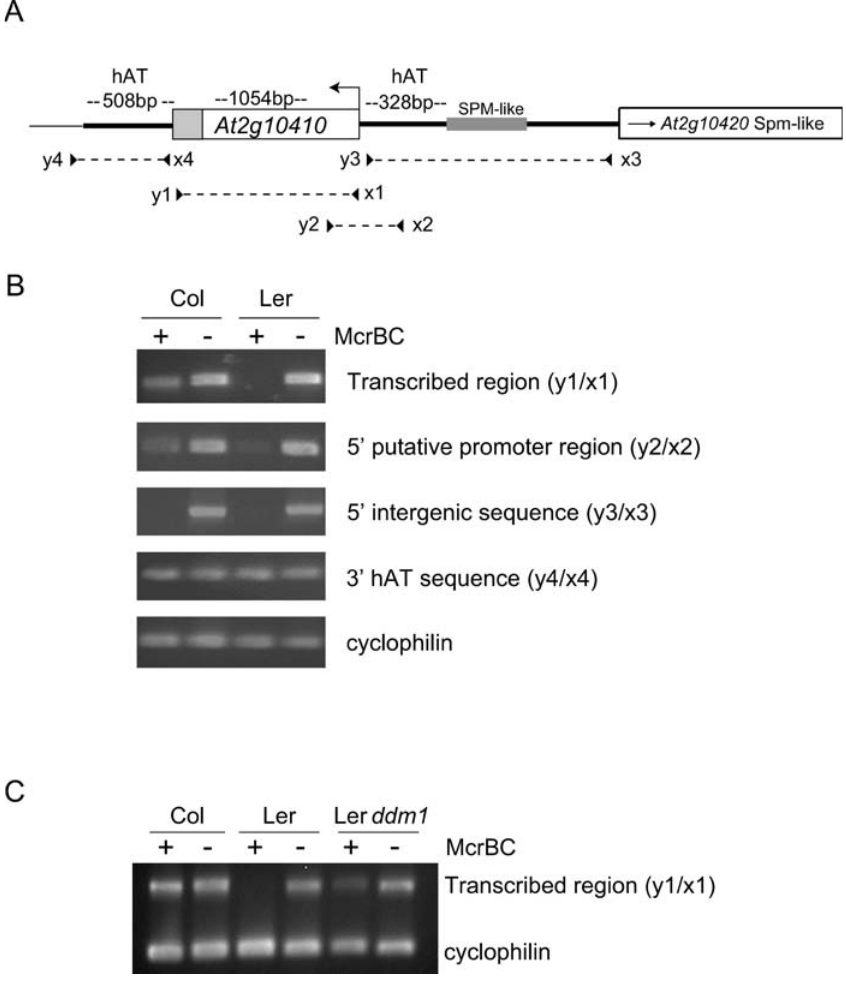
Figure 3. Analysis of Cytosine Methylation at At2g10410 by McrBC Digestion followed by PCR (A) Diagram of the At2g10410 locus in Col including nearby repetitive elements and intergenic regions. Arrow indicates start and direction of transcription. The positions of primers used for PCR analysis are indicated as triangles. (B) PCR amplification of genomic DNA þ / (cid:1) McrBC digestion. Cyclophilin is shown as an amplification control. (C) McrBC PCR of the At2g10410- transcribed region in Col, Ler, and Ler ddm1–2 genomic DNA samples. Cyclophilin is shown as an internal amplification